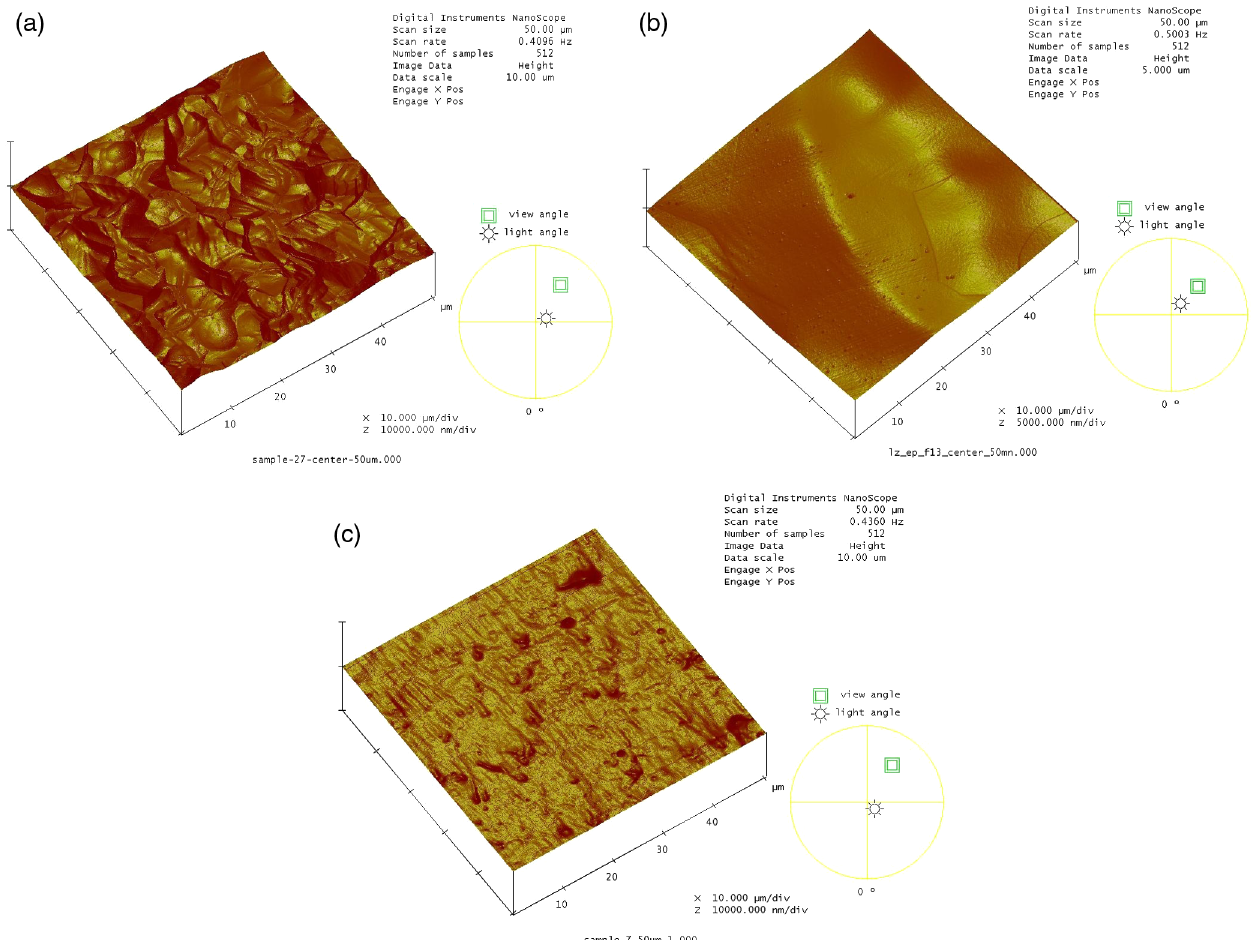
FIG. 10. AFM images of niobium surface after: (a) BCP; (b) EP; (c) centrifugal barrel polishing (CBP). Scan size was 50 μ m × 50 μ m. Horizontal scale: 10 μ m per division. Vertical scale: 10 μ m per division (a) and (c) and 5 μ m per division